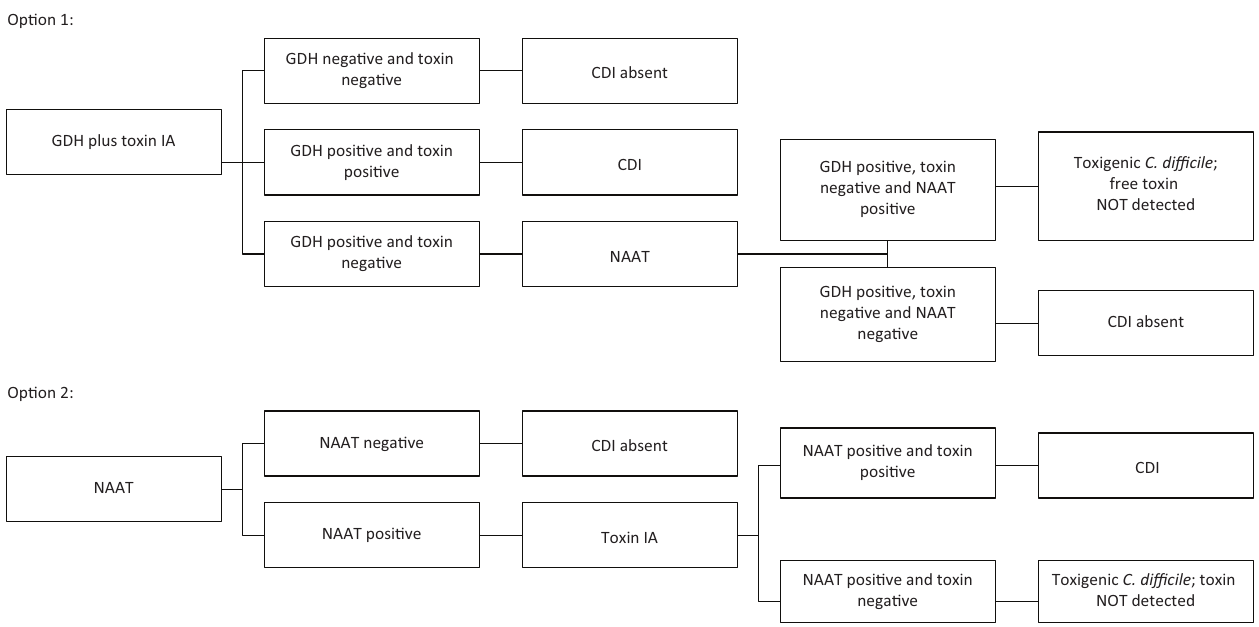
FIGURE 1: Testing algorithms and results